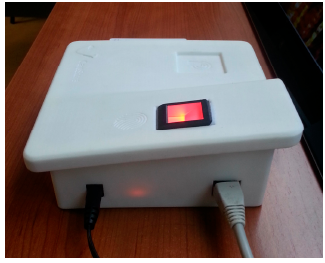
Figure 11. Top view of the second prototype.